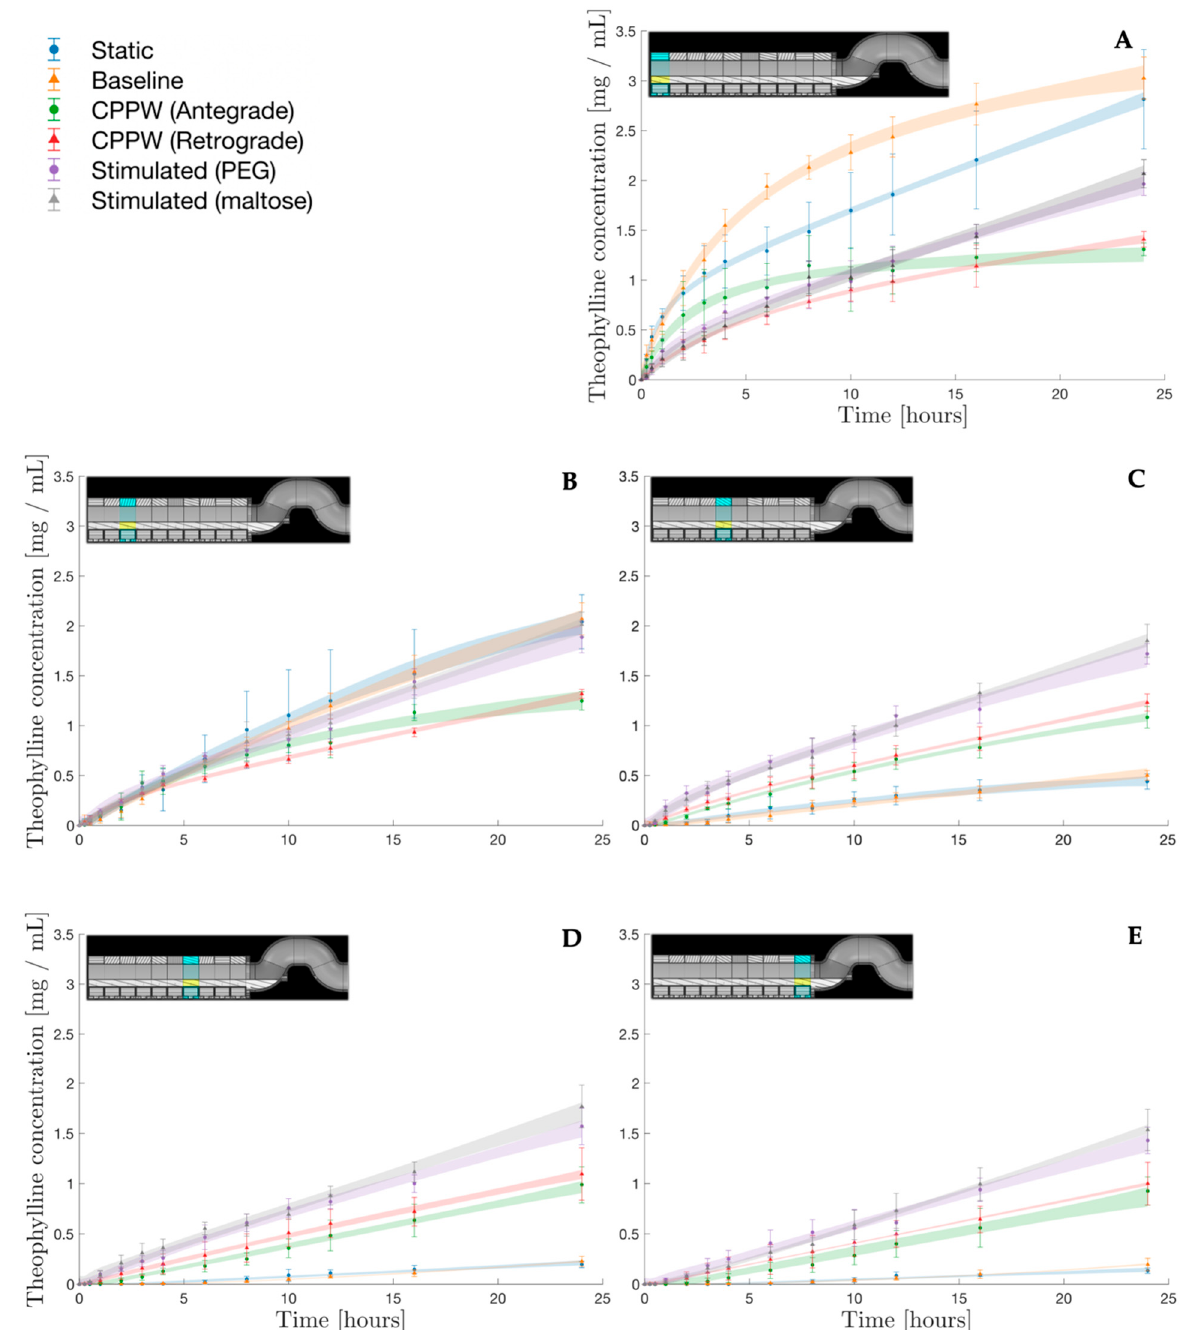
Figure 4. Concentration profiles of theophylline in segments S1 ( A ), S3 ( B ), S5 ( C ), S7 ( D ) and S10 ( E ) of the DCM under different motility